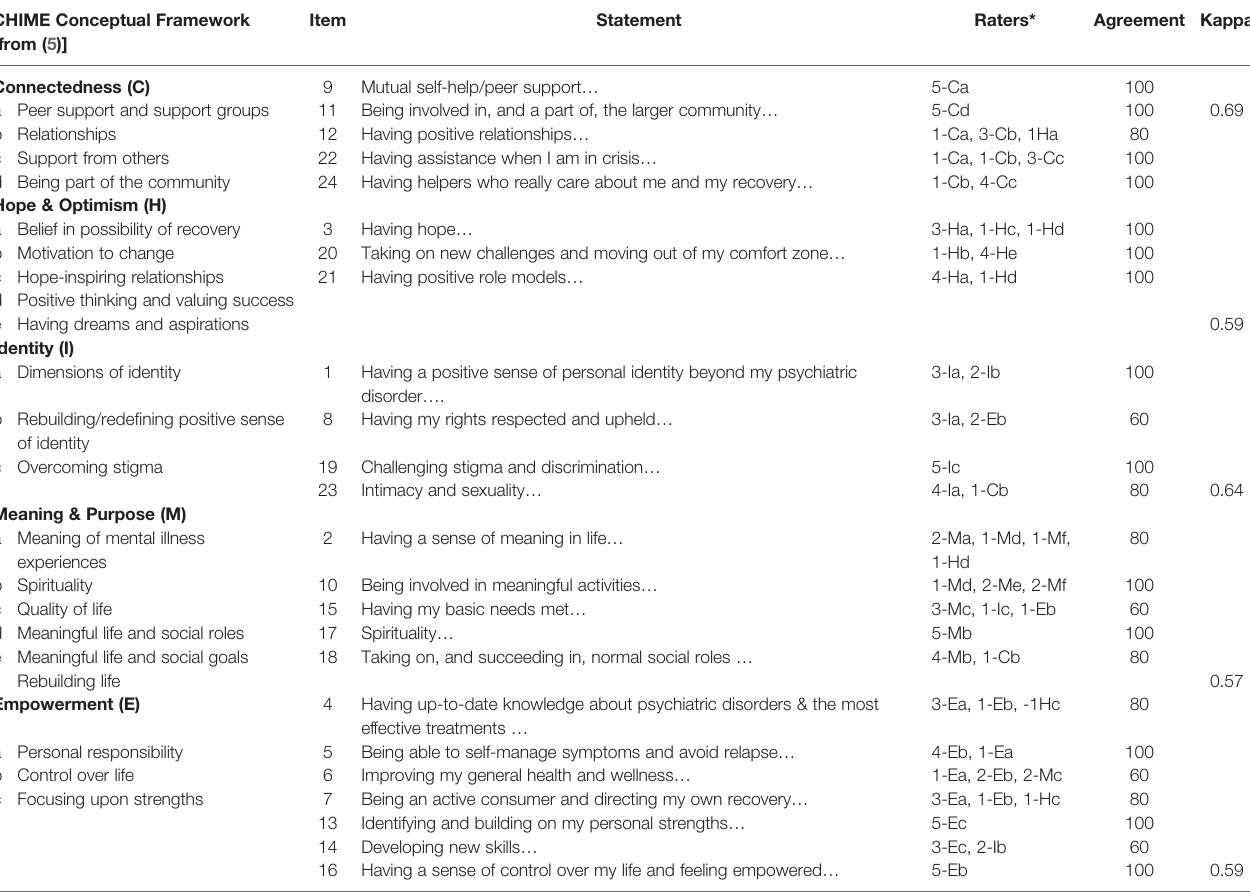
TABLE 2 | CHIME conceptual framework, percentage agreement and kappa coef fi cients of the REE instruments item. CHIME Conceptual Framework [from